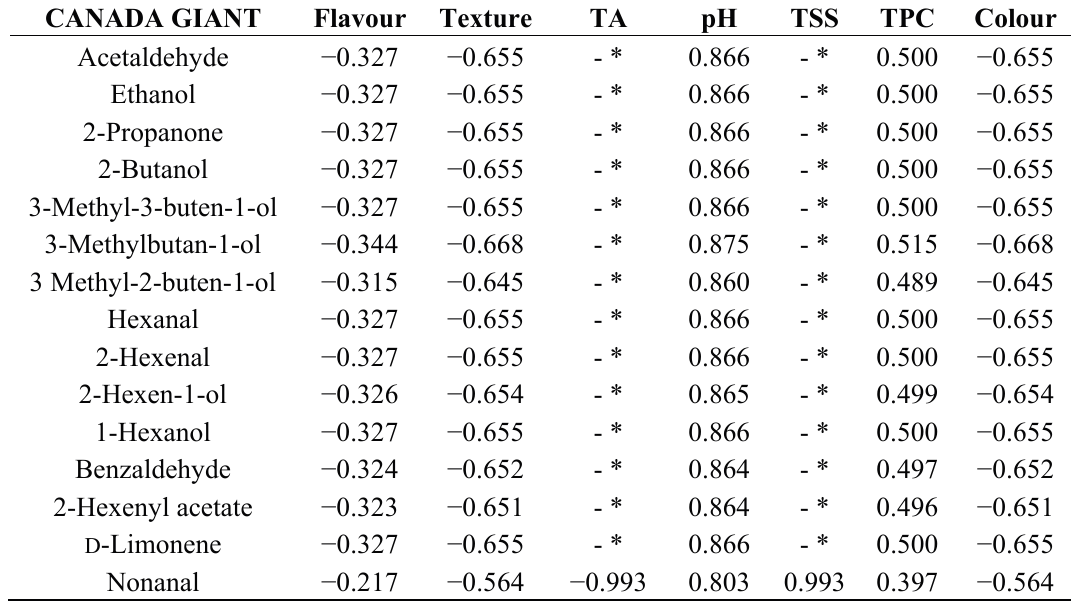
Table 4. Correlation between volatile compounds and physicochemical/sensory attributes in the Canada giant cultivar.